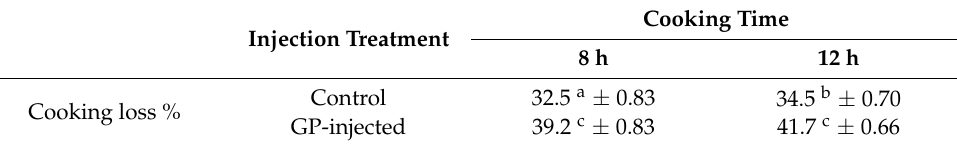
Table 5. Effect of injection treatment (GP injection = injection with ginger powder solution containing zingibain; Control = without injection) and cooking time (8 h, 12 h), on the cooking loss of M. biceps femoris cooked at 65 ◦ C under sous vide. Data are presented as mean ± SE. Superscripts refer to significant differences in the mean values and a similar letter describes non-significance between treatments.